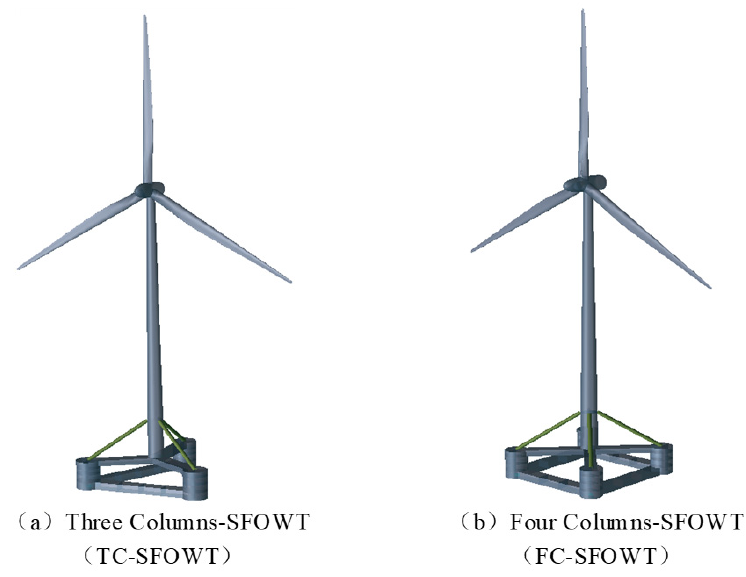
Figure 1. Overall model of SFOWTs.